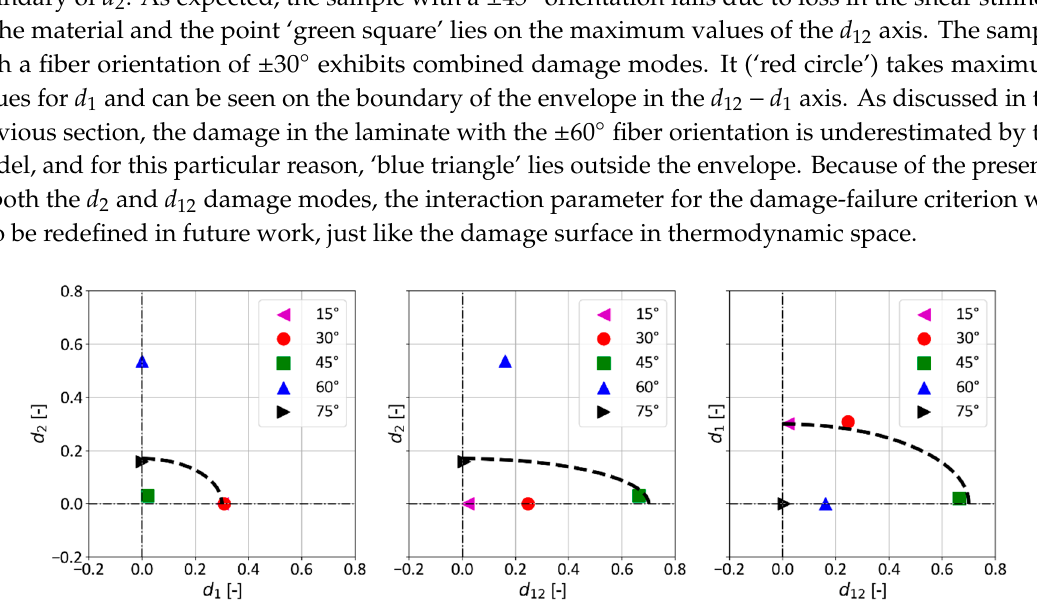
Table 6. Stress limits for stress-based Tsai-Wu failure criterion where superscripts ‘ T ’ and ‘C’ denote tension and compression, respectively.